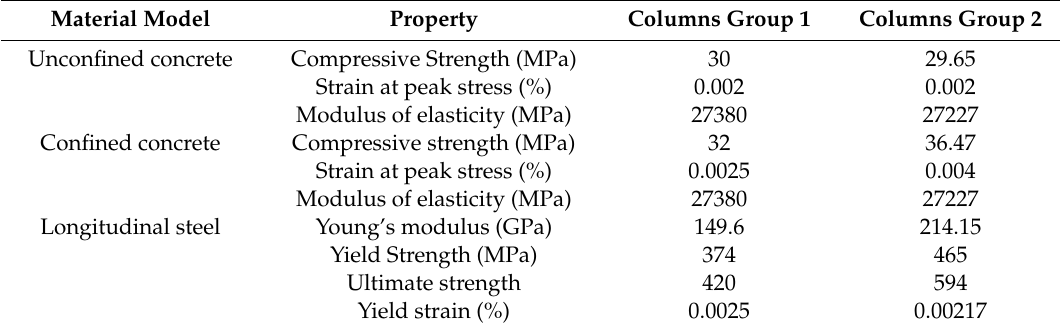
Table 6. Material properties used in the model.